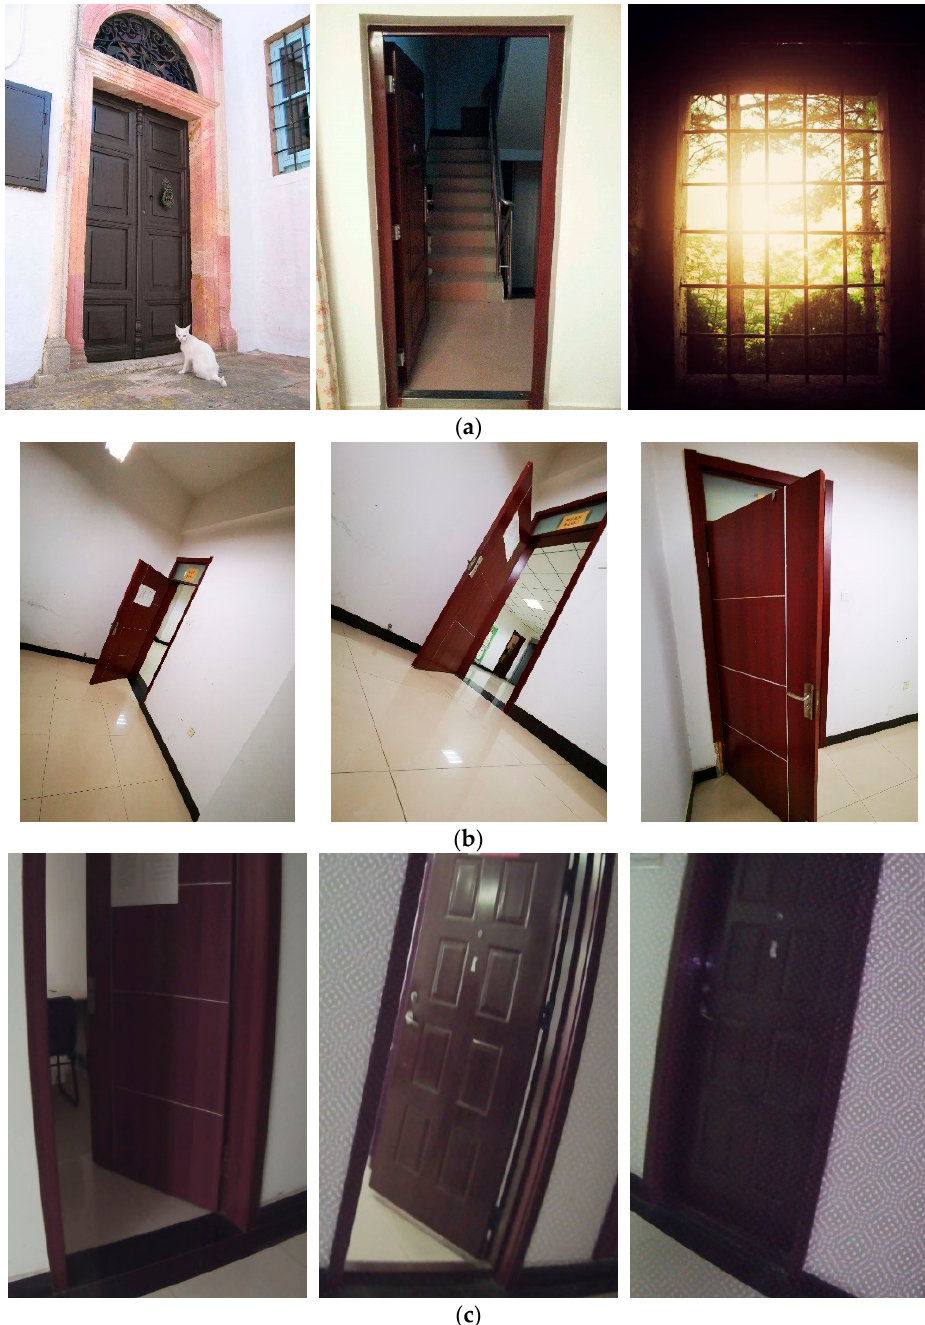
Figure 5. The dataset used in the experiment. ( a ) Public image. ( b ) Mobile phone camera shot. ( c ) Binocular camera (left eye) shot.